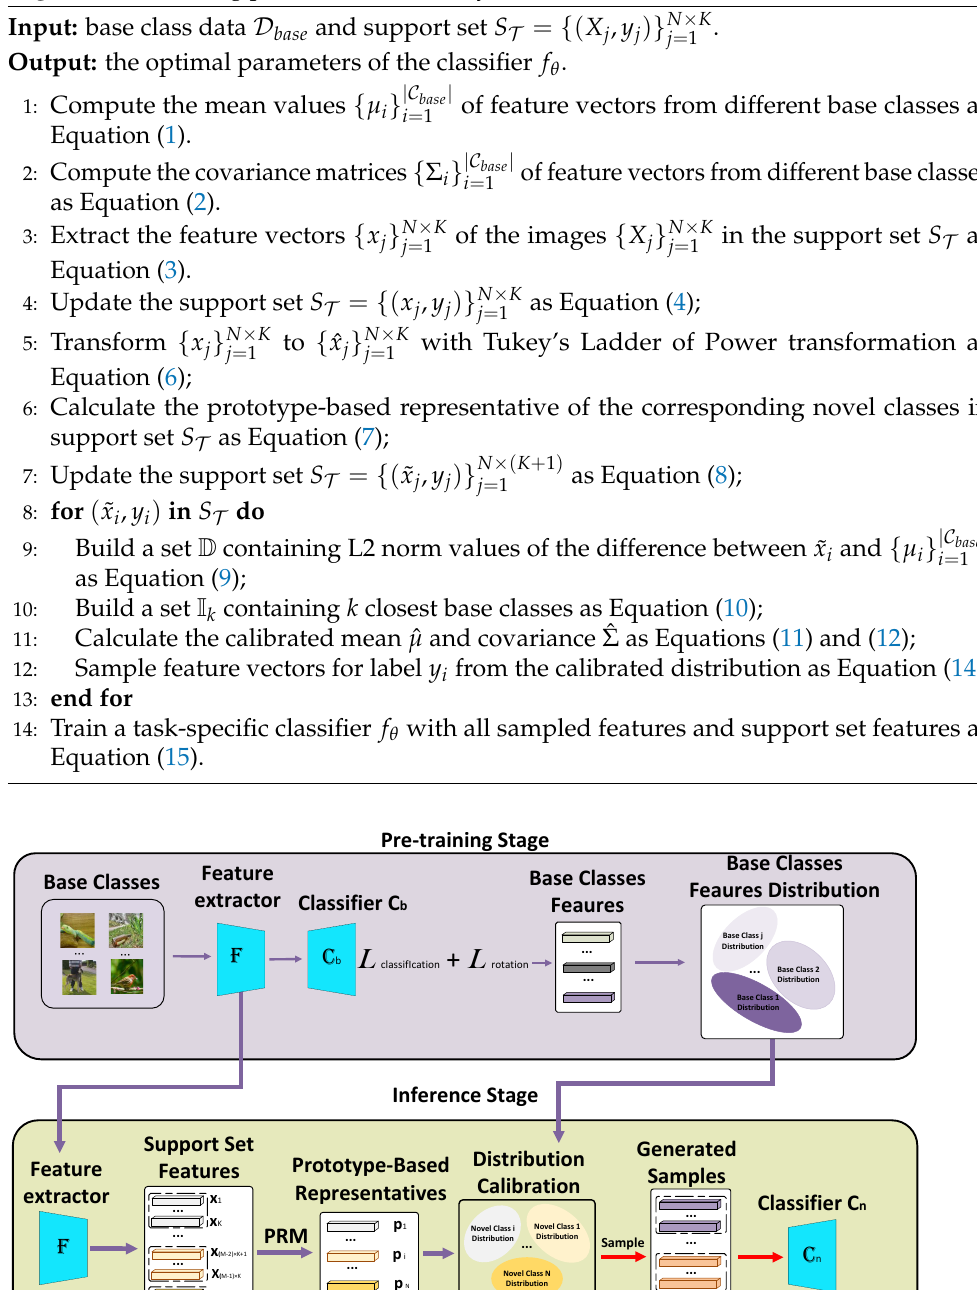
Algorithm 1 Training process on the N -way- K -shot task